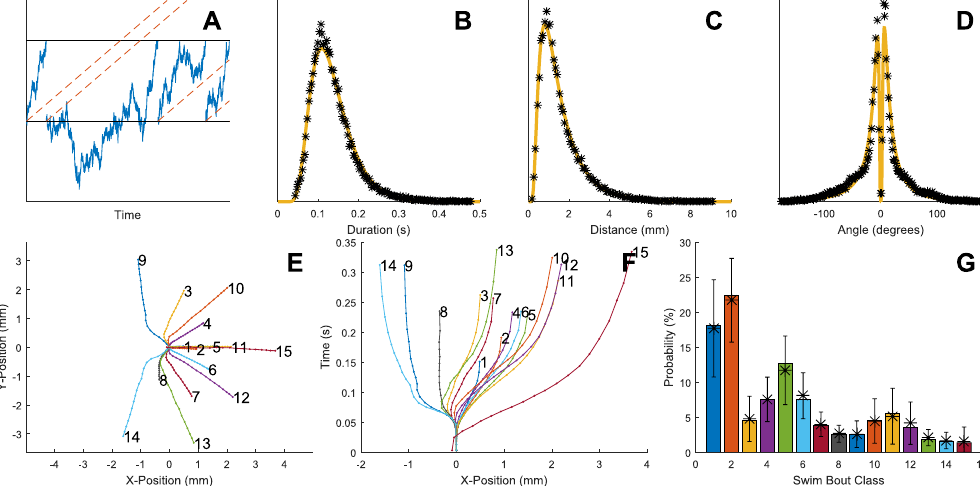
Figure 2. Characterization of swimming bouts based on kinematic features. ( A ) Schematic representation of the underlying assumptions of the Ornstein–Uhlenbeck model. Transitions in behavior occur when the state of the network controlling the behavior passes a certain threshold (upper line). The state of the network is at any point described by a random-walk process which will eventually lead to spontaneous transitions events. In addition, a command signal that actively pushes the state towards the threshold may be present (indicated by the dashed lines). ( B – D ) Distributions of kinematic features extracted for each bout (total n = ∼ 120,000), ( B ) bout duration, ( C ) bout distance and ( D ) turning angle. Yellow lines denote fitting of the Ornstein–Uhlenbeck model to experimental data and asterisks show binning density. ( E,F ) Classification of swimming trajectories reveals differences between swimming behavior observed in individual bouts. ( E ) Trajectories representing the mean trajectories of 15 bout types identified by the algorithm are shown in the horizontal plane (x-y). ( F ) The trajectories in ( E ) shown with time from bout on-set on the y-axis (x-t). The apparent earlier onset of type 15 is caused by data subsampling (see Methods). ( G ) The relative frequency of the number of observed bouts of each type (class code as in E-F; showing that shorter and straight bouts tend to be more common). Whiskers denote mean and SD of the distribution over all individuals – note the relatively small SD and that the pooled probability (bars) closely matches the average over individuals (asterisks) indicating a small inter-individual